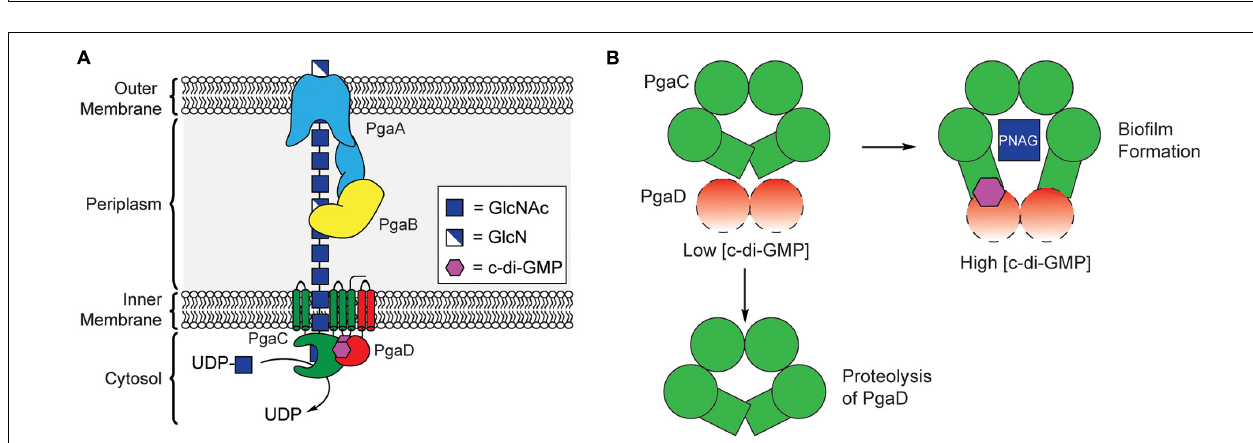
FIGURE 4 | Pel polysaccharide biosynthesis is activated by c-di-GMP binding to the GGDEF domain of PelD. (A) Organization of the machinery for Pel polysaccharide biosynthesis in P. aeruginosa . (B) Binding of c-di-GMP dimer to the GGDEF domain (cyan) of PelD results in a 14 ◦ rotation of the GAF domain (green, PDB id 4DN0) relative to the structure of PelD in the absence of c-di-GMP (white, PDB id 4DMZ).